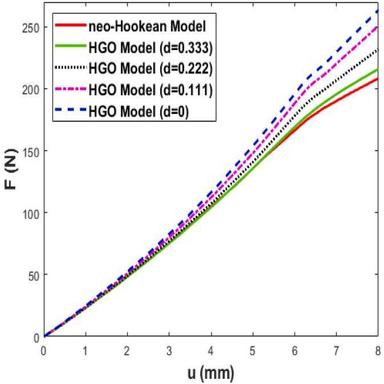
Influence of fibre dispersion in TA on the overall response of penile tissue in compression testing (α = 90).